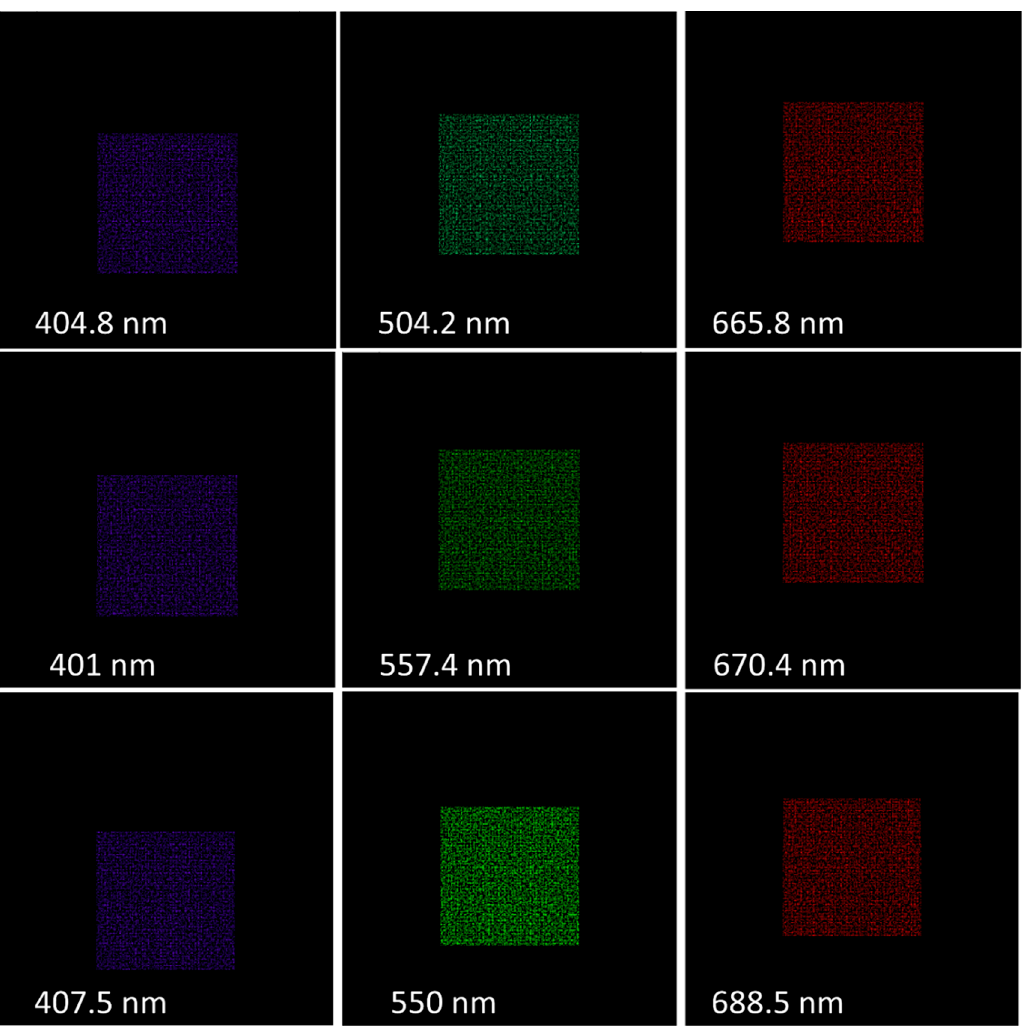
Figure 10. Images of the coded aperture mask using the TracePro TM color scheme for a selection of six calibration frames under sequential illumination of monochromatic light for three air gap distances of the dual-prism: 4.24 mm ( upper row ), 4.64 mm ( middle row ) and 5.04 mm ( bottom row).